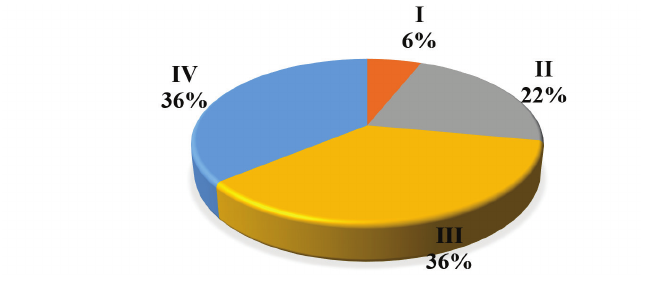
Figure 3. Division and distribution of CRC patients based on different stages of cancer